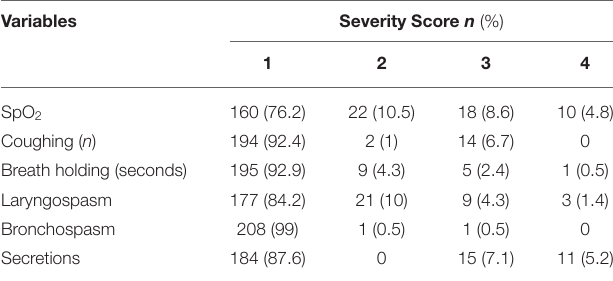
TABLE 4 | Severity of perioperative respiratory adverse events among pediatric surgical patients underwent surgery under general anesthesia at UoGCSH and TGSH, Northwest Ethiopia; March 1–May 30, 2020 ( N =